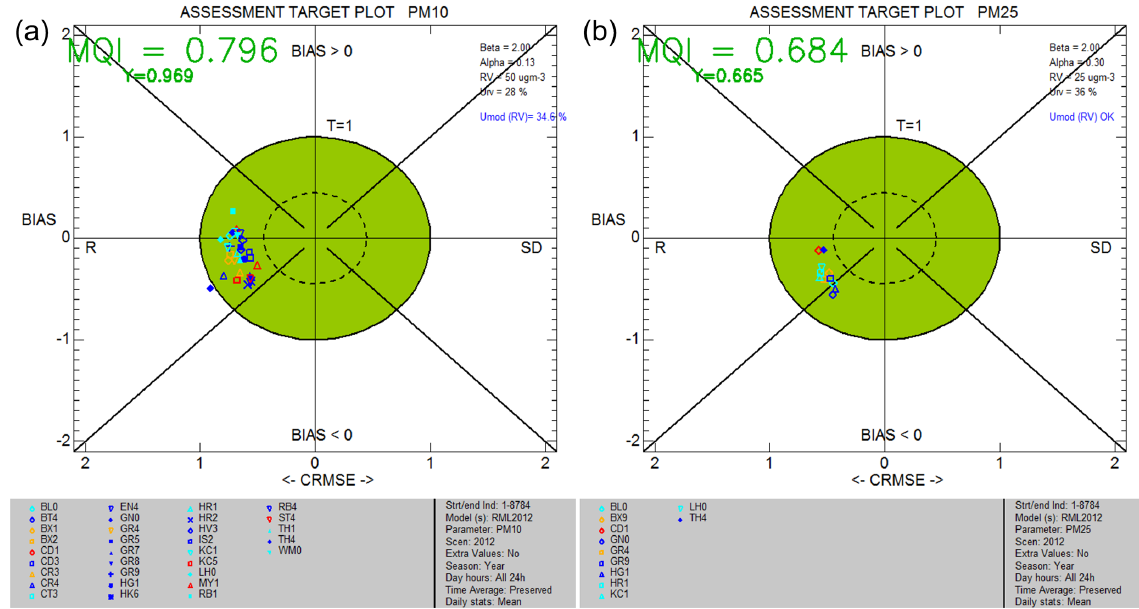
Figure 9. Model assessment target plots for PM 10 (a) and PM 2 . 5 (b) for coupled system outputs. Each symbol represents a single station and the distance between the origin and the symbol corresponds to the MQI for that station; the ordinate and abscissa correspond to the bias and CRMSE respectively. Good model performance is indicated by points within the green